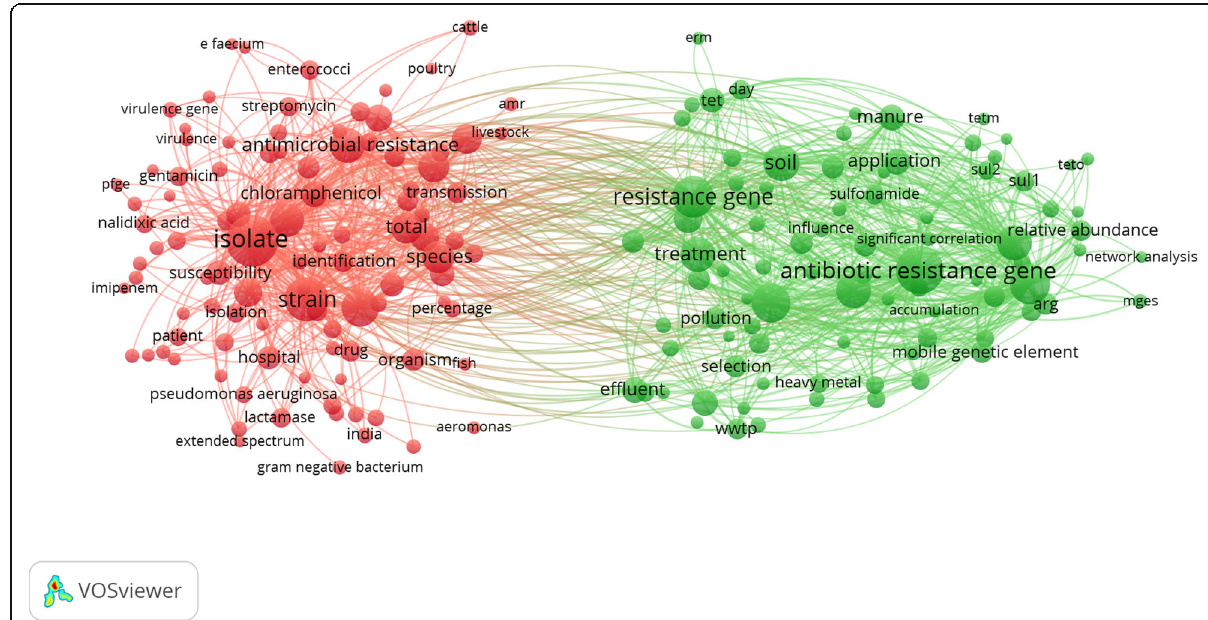
Fig. 2 Network visualization map of most frequent terms in titles/abstracts of the retrieved literature on AMR in the environment (2000 – 2019). The two clusters represent the major research themes in the retrieved literature